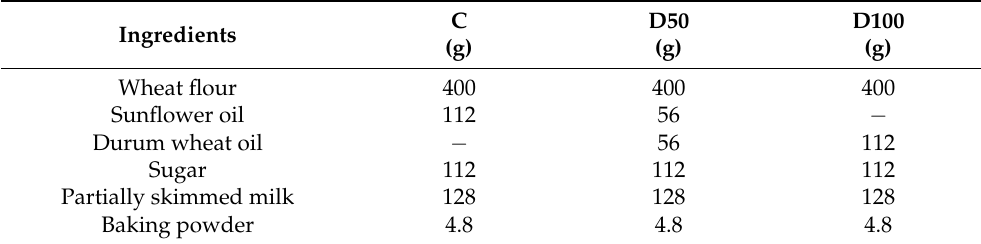
Table 1. Formulation of the experimental biscuits. C = Biscuits prepared with 100% sunflower oil; D50 = biscuits prepared with sunflower oil (50%) and durum wheat oil (50%); D100 = biscuits prepared with 100% durum wheat